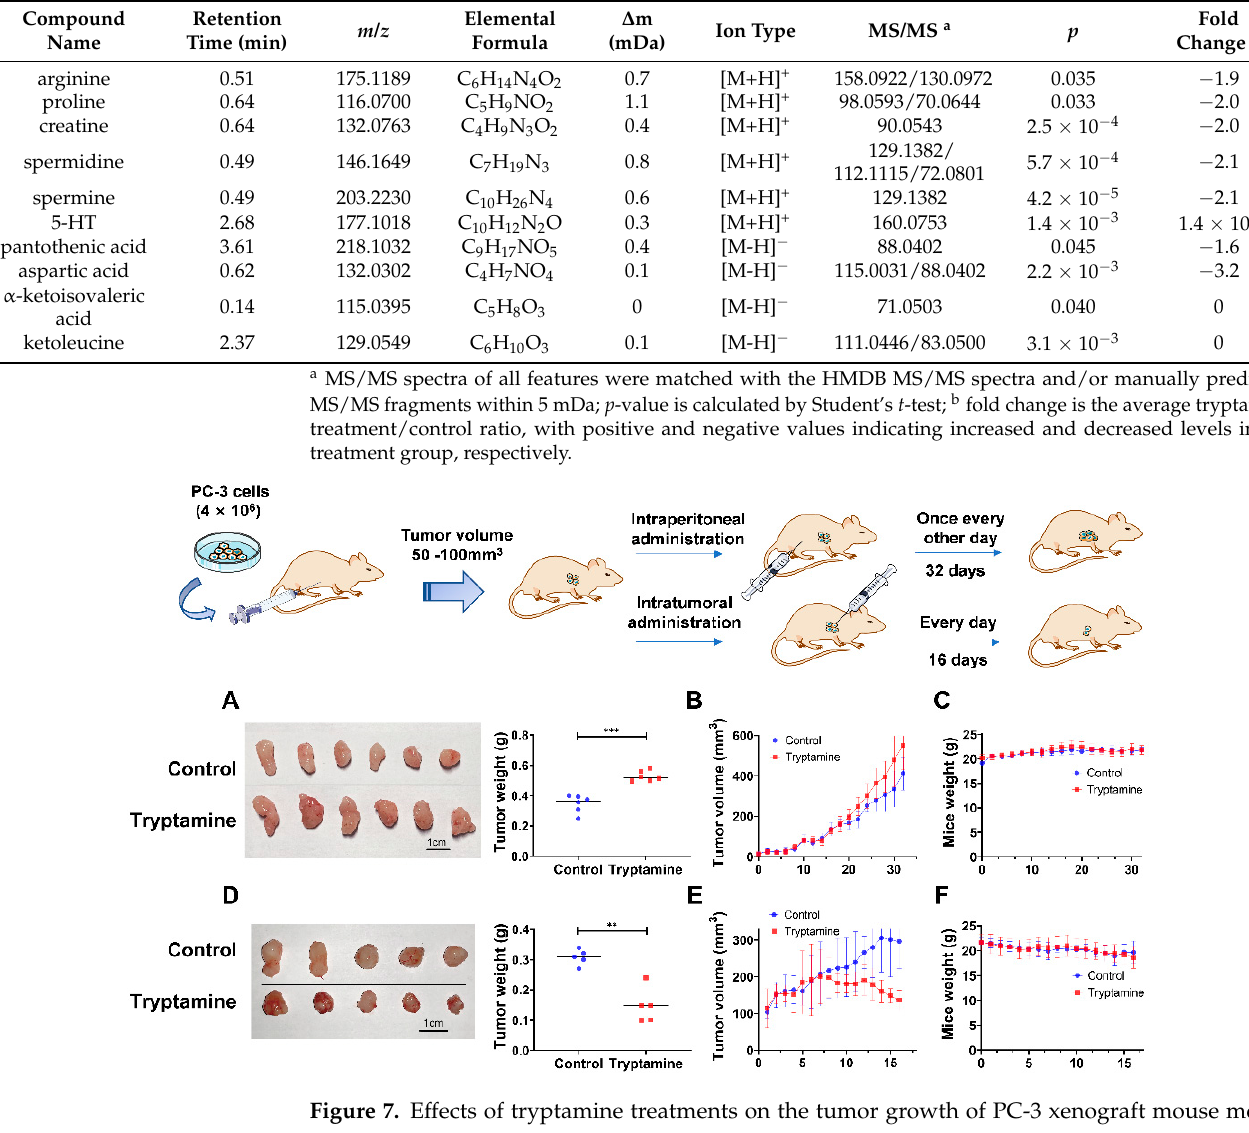
Table 3. Tentative identification of differential metabolites of PC-3 cells between control and tryptamine treatment groups.